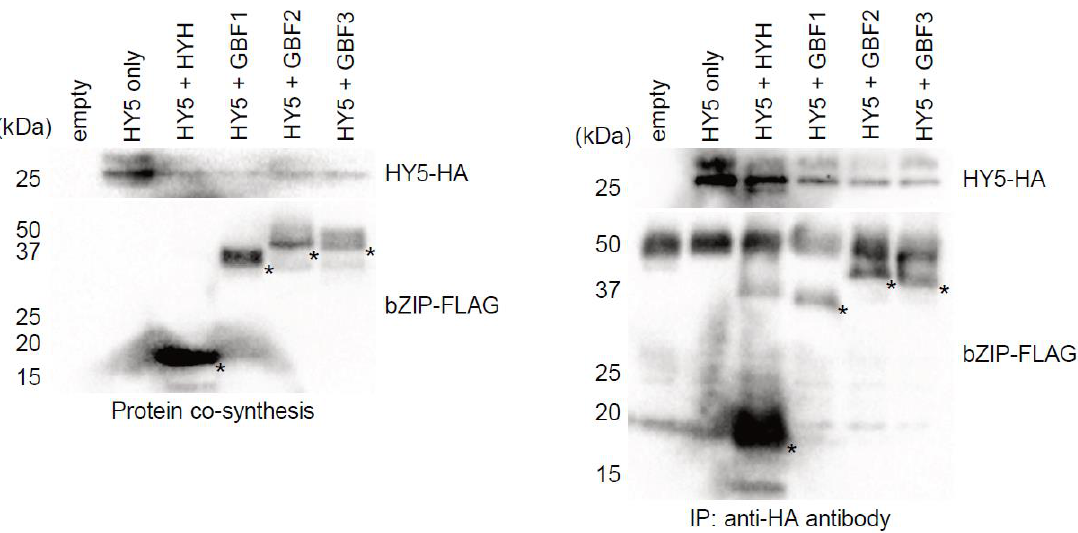
Figure 6. In vitro interaction between HY5 and other bZIP TFs. Detection of recombinant proteins by Western blot analysis before ( A ) and after ( B ) immunoprecipitation. HA-tagged HY5 was co-synthesized with FLAG-tagged HYH, GBF1, GBF2 or GBF3 proteins in wheat germ extract and then immunoprecipitated with anti-HA antibodies.